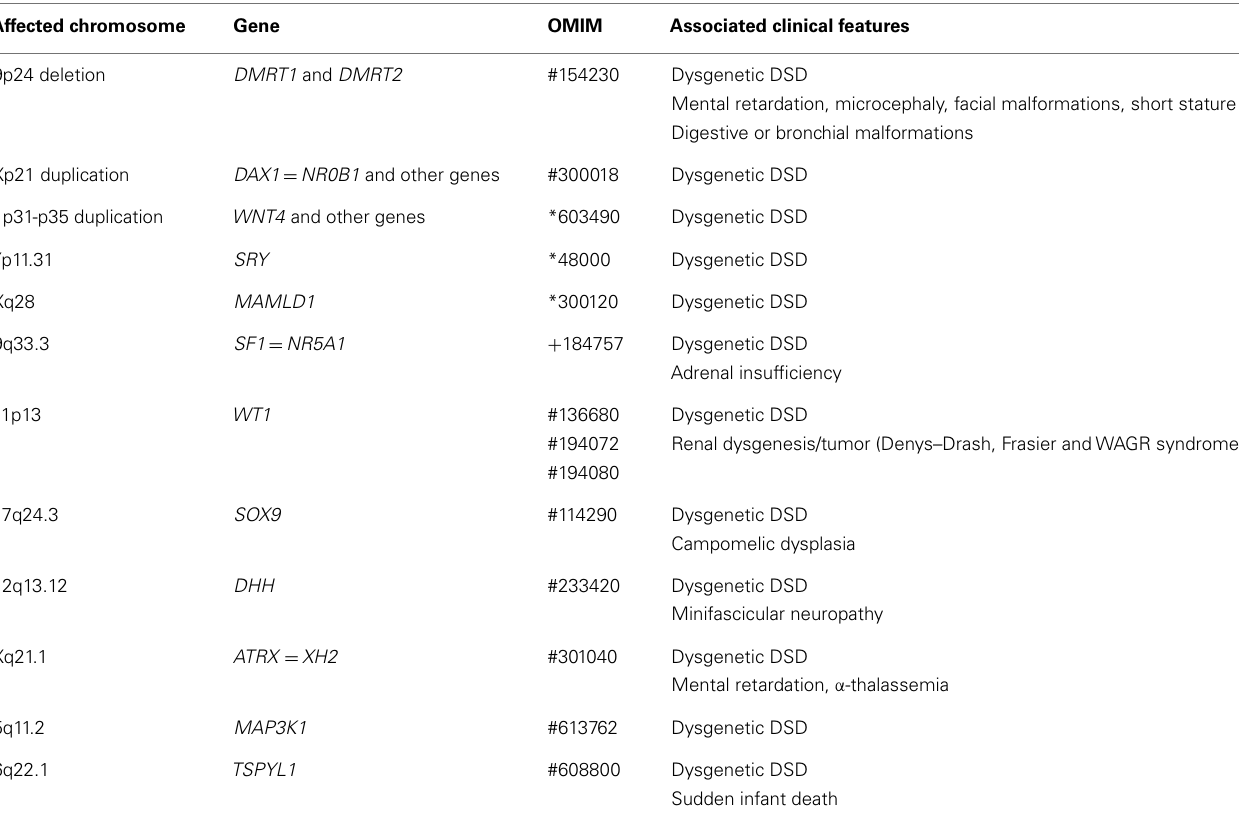
Table 2 | Clinical features in male patients with fetal-onset primary hypogonadism with whole gonadal dysfunction. Affected